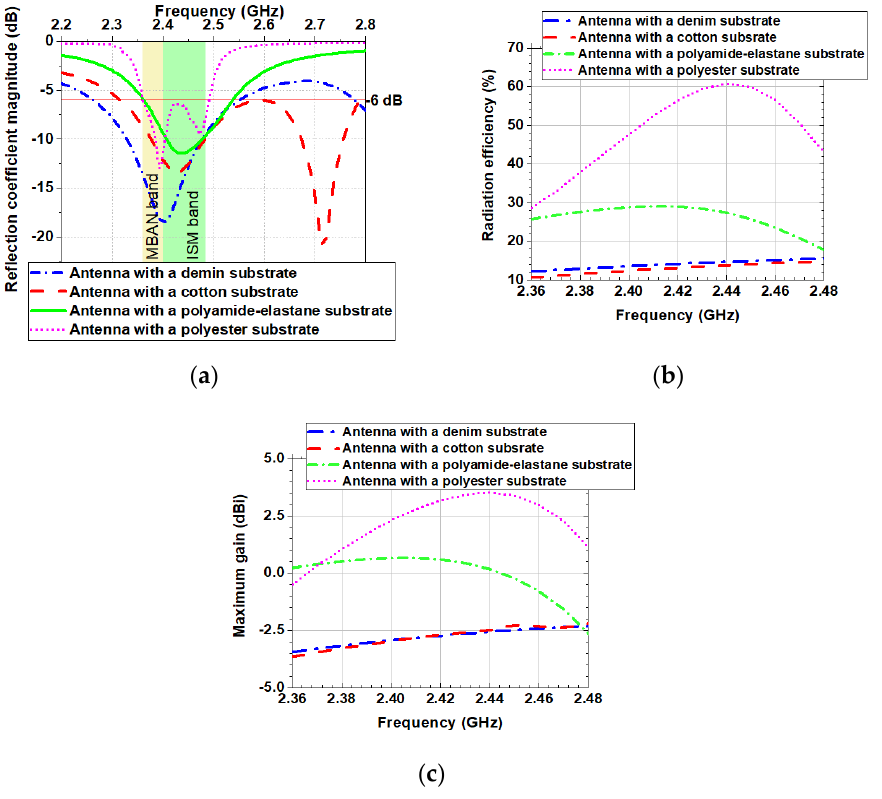
Figure 10. Simulated in the free space: ( a ) Reflection coefficient magnitudes versus frequency; ( b ) Radiation efficiency versus frequency; ( c ) Maximum gain versus frequency.